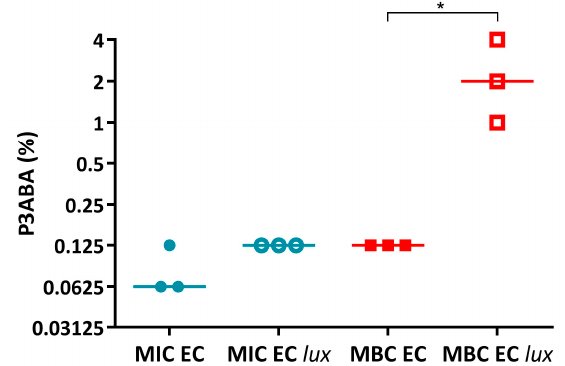
Figure A2. Activity of P3ABA against E. coli 25922 and E. coli 25922 lux. The MIC (circles) and MBC (squares) of PANI against E. coli 25922 (EC) and E. coli 25922 lux (EC lux ) in LB broth. Data obtained from E. coli 25922 is represented by filled data points while data obtained from E. coli 25922 lux is represented by unfilled data points. Statistical significance is represented by * (Mann-Whitney test, p value: less than 0.05).